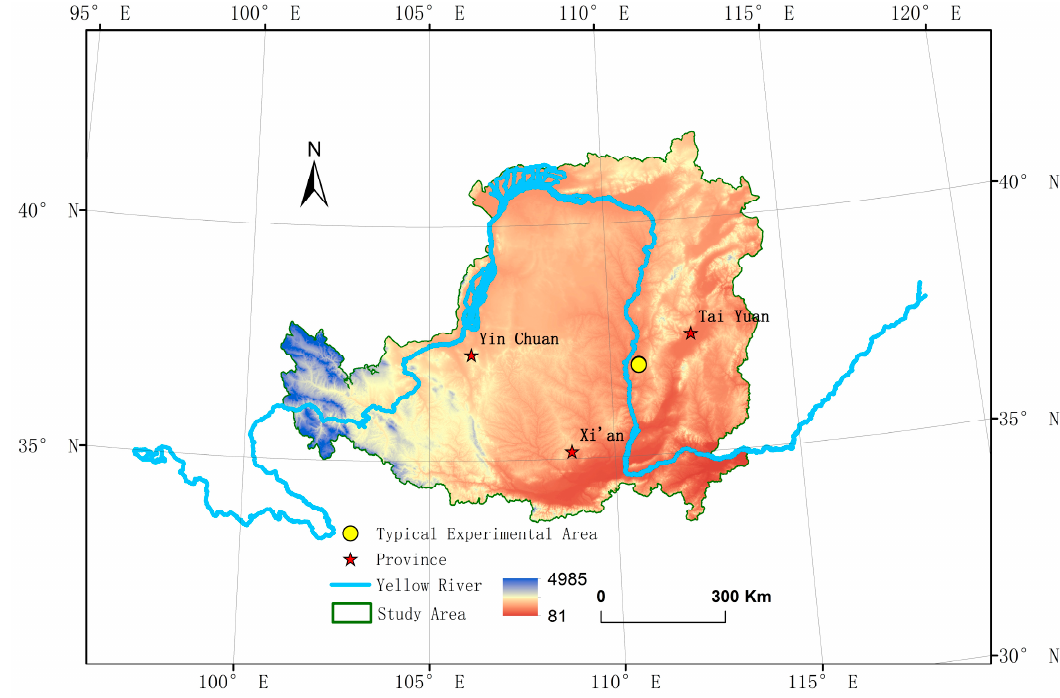
Figure 2. Location of the typical experimental area.